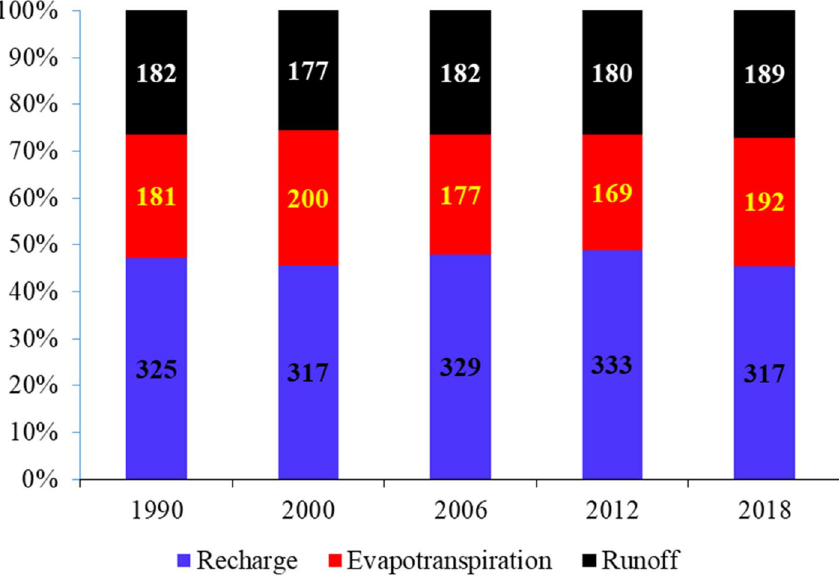
Figure 7. Average yearly water balance components for the Drava floodplain from 1990 to 2018 (values are in mm year −1 ).